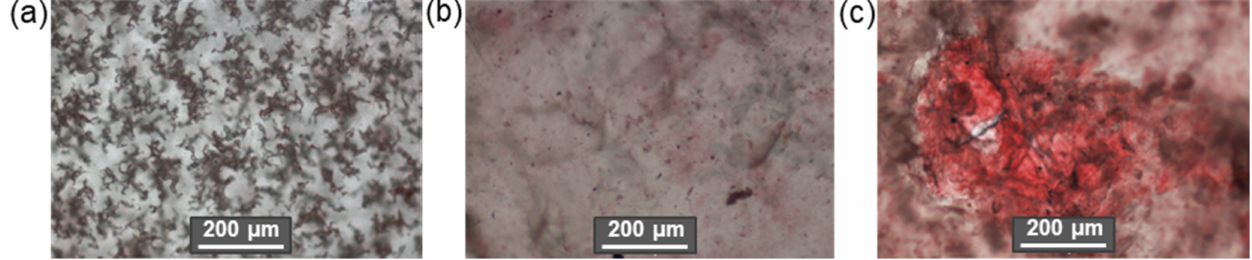
Figure 21. In vitro mineralization study by optical microscopy of pure PCL ( a ) and its composites with 15 wt% neat CNC ( b ) and 15 wt% CNC modified with PGlu ( c ). Staining was performed with alizarin red S. Red color indicates the presence of calcium deposits (reproduced from [224] under the terms of the Creative Commons CC BY